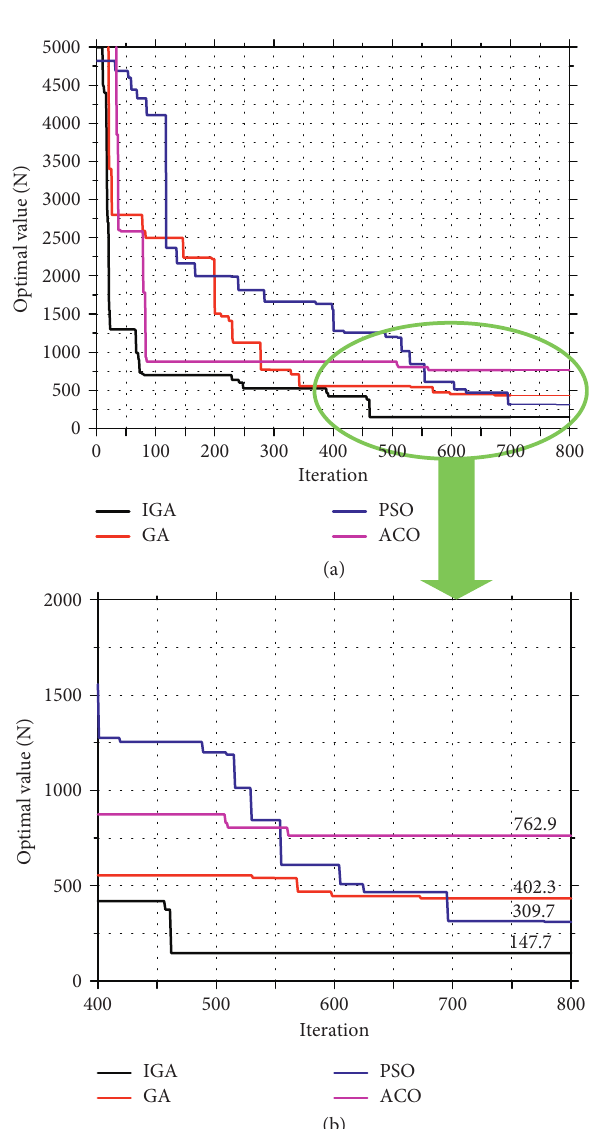
Figure 6: Result comparison of five consecutive calculations.